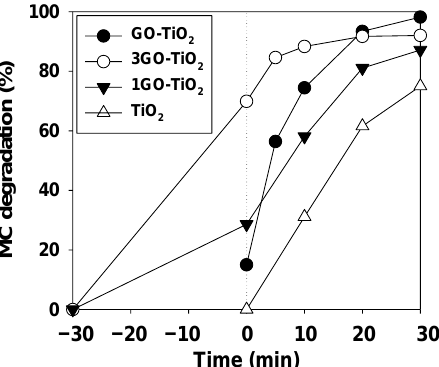
Figure 2. MC photodegradation (20 mg/L) at catalyst concentration of 800 mg/L under UV radiation. TiO 2 (white triangles), ½ GO-TiO 2 (so-called GO-TiO 2 ) (black circles), 1GO-TiO 2 (black triangles), and 3GO-TiO 2 (white circles).